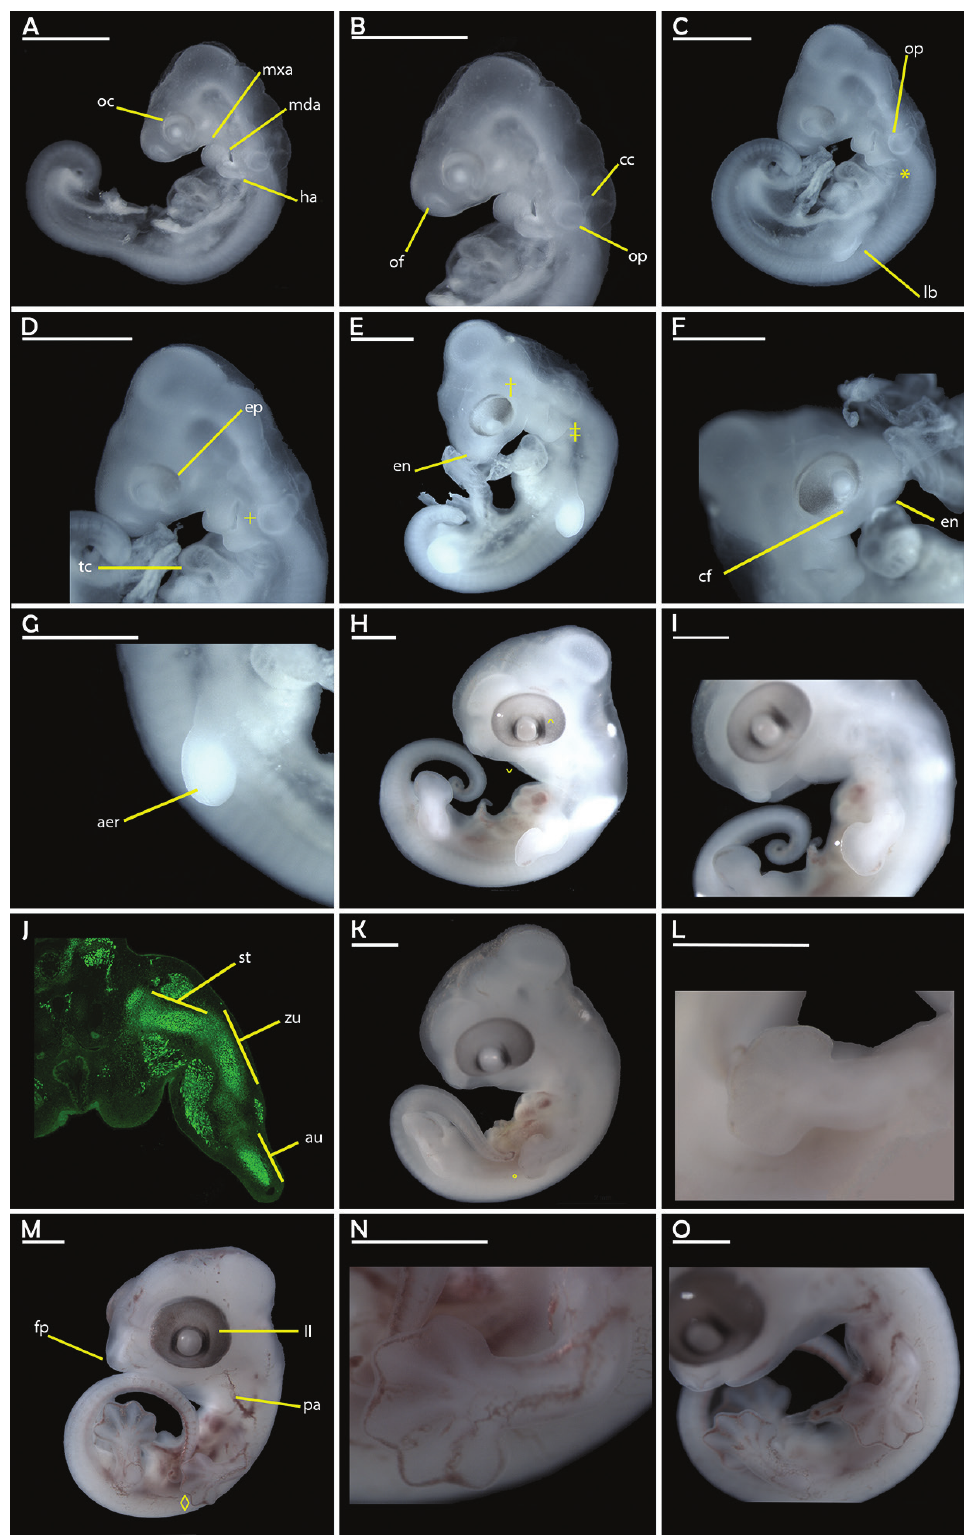
Figure 2. Overview of embryonic developmental stages A to F, erected in this study. Stage A is depicted in (A, B) and represented by CA2017_007. (C, D) show the representative CA2017_003 for stage B. Stage C (E–G) is represented by CA2017_006. CA2017_005 rep- resents stage D in (H–J) . Note the immunohistochemistry for SOX9 expression in a limb cross section in (J) . Stage E is shown in (K–L) , represented by CA2017_010. CA2017_012 represents stage F in (M-O) . Except for (J) , all pictures in lateral view. Scale bars equal